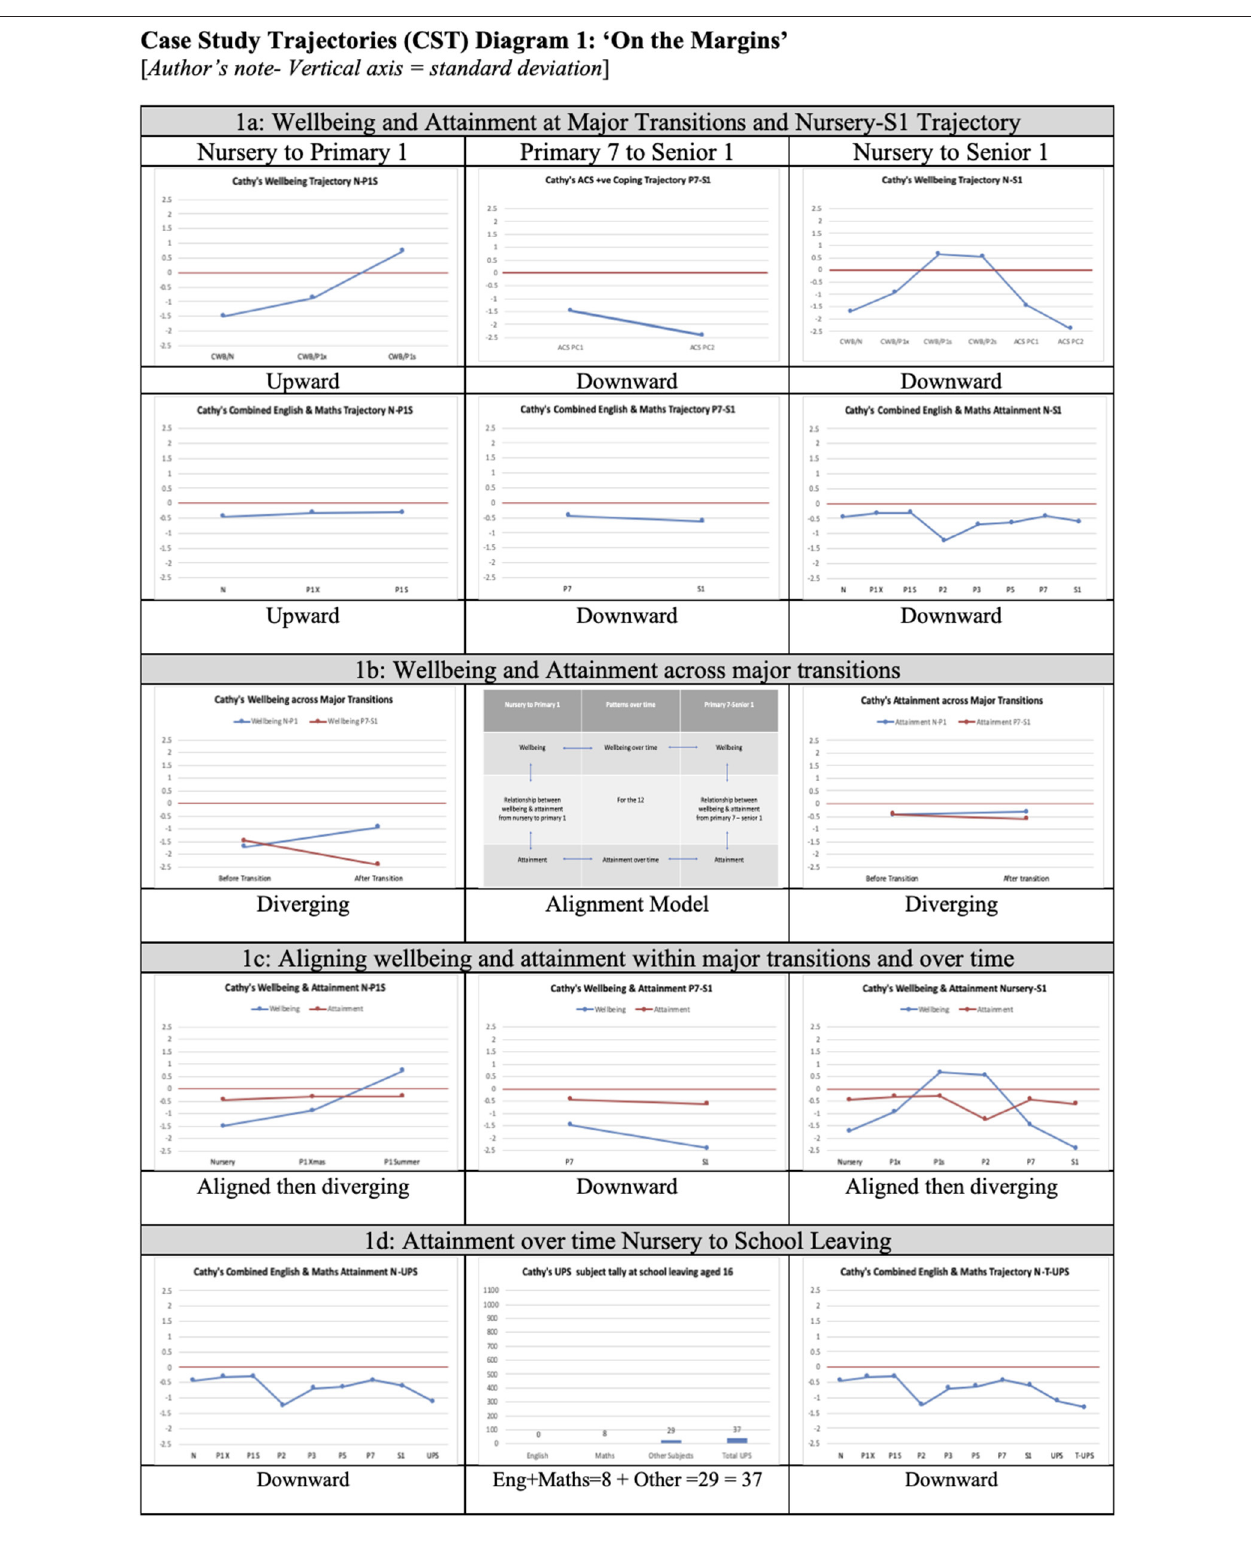
DIAGRAM 1 | Case Study Trajectories (CST) Diagram 1 – ‘On the